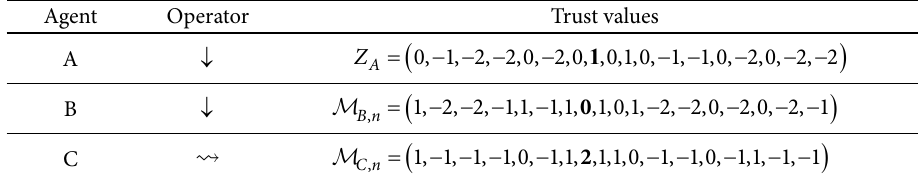
Table 1. Properties of agents A, B and